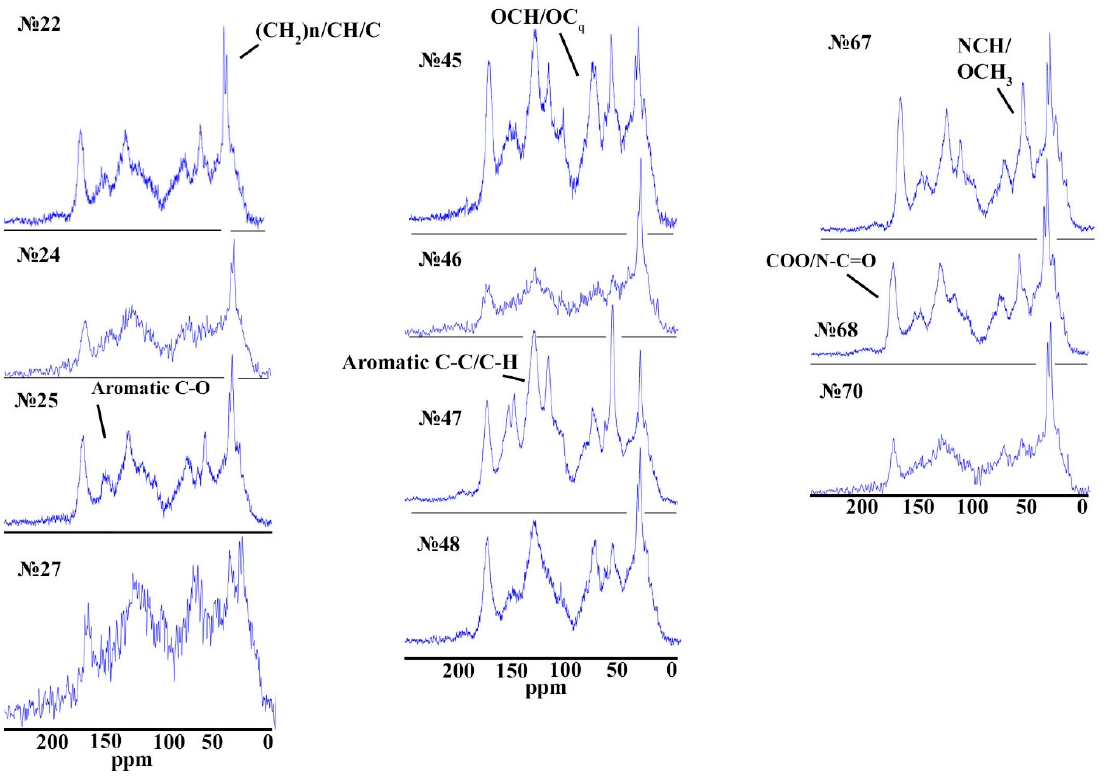
Figure 4. 13 C-NMR spectra of the studied HAs. Soil ID correspond to Table 3. The functional groups are presented on subfigure. Table 3. Percentage ratio of the main structural fragments of